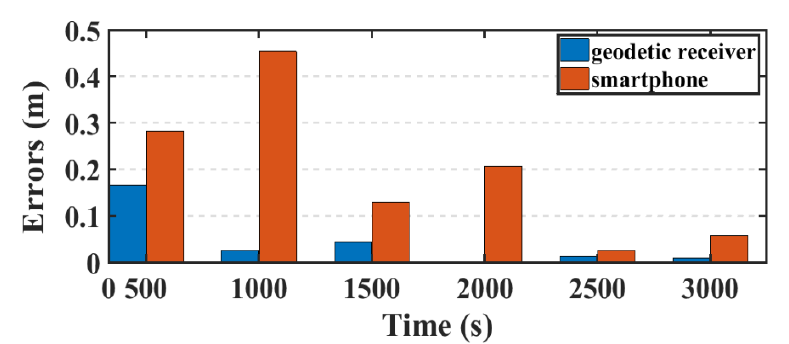
Figure 15. Position errors in North direction (meters).